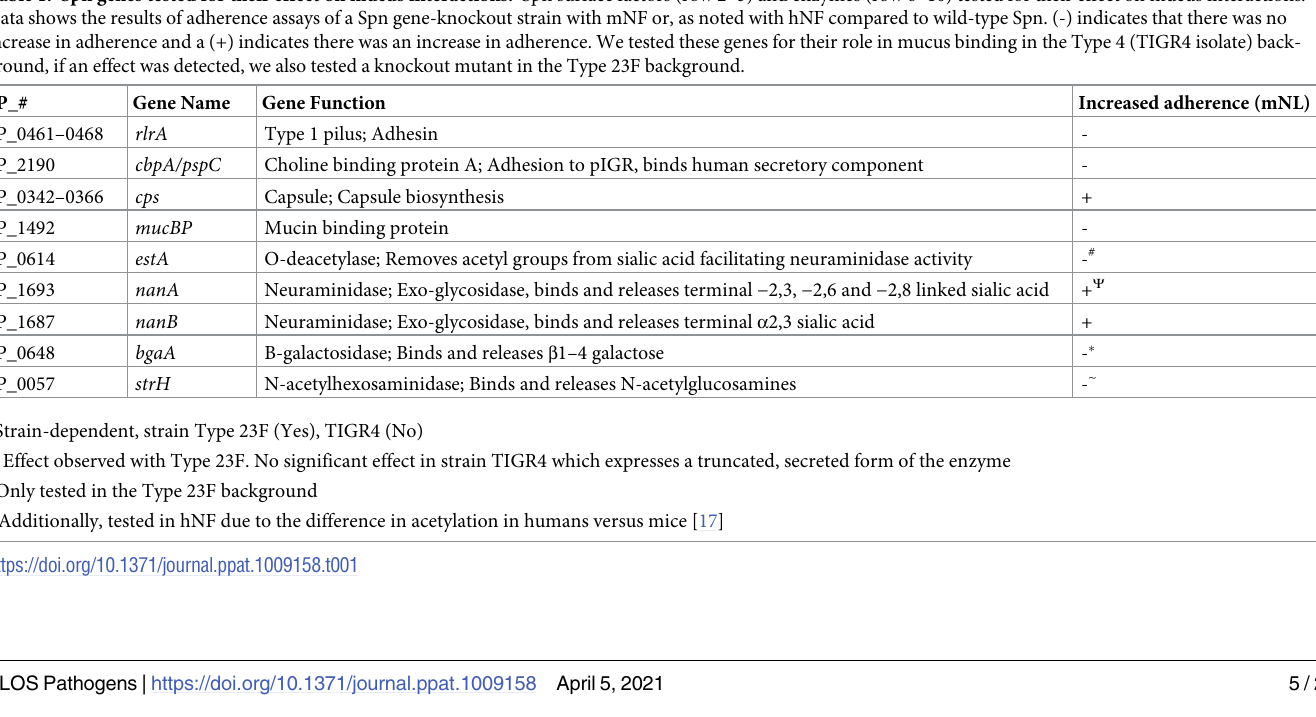
Table 1. Spn genes tested for their effect on mucus interactions. Spn surface factors (row 2–5) and enzymes (row 6–10) tested for their effect on mucus interactions. Data shows the results of adherence assays of a Spn gene-knockout strain with mNF or, as noted with hNF compared to wild-type Spn. (-) indicates that there was no increase in adherence and a (+) indicates there was an increase in adherence. We tested these genes for their role in mucus binding in the Type 4 (TIGR4 isolate) back- ground, if an effect was detected, we also tested a knockout mutant in the Type 23F background.